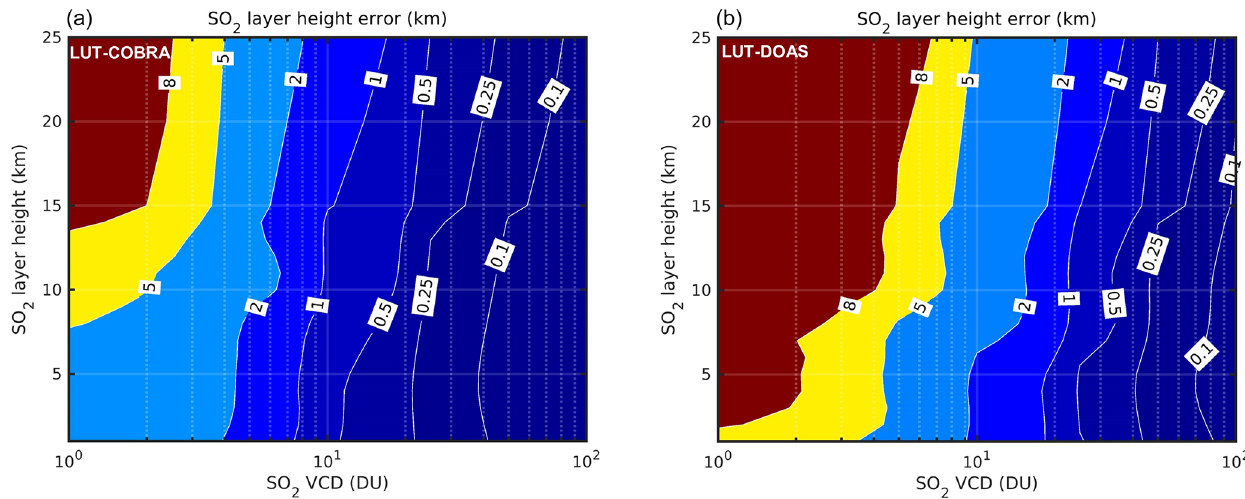
Figure 2. SO 2 layer height theoretical uncertainty for (a) LUT-COBRA and (b) LUT-DOAS schemes. The results correspond to SZA: 30 ◦ , VZA: 0 ◦ , RAA: 0 ◦ , ozone column: 295DU, surface height: 0km, surface albedo: